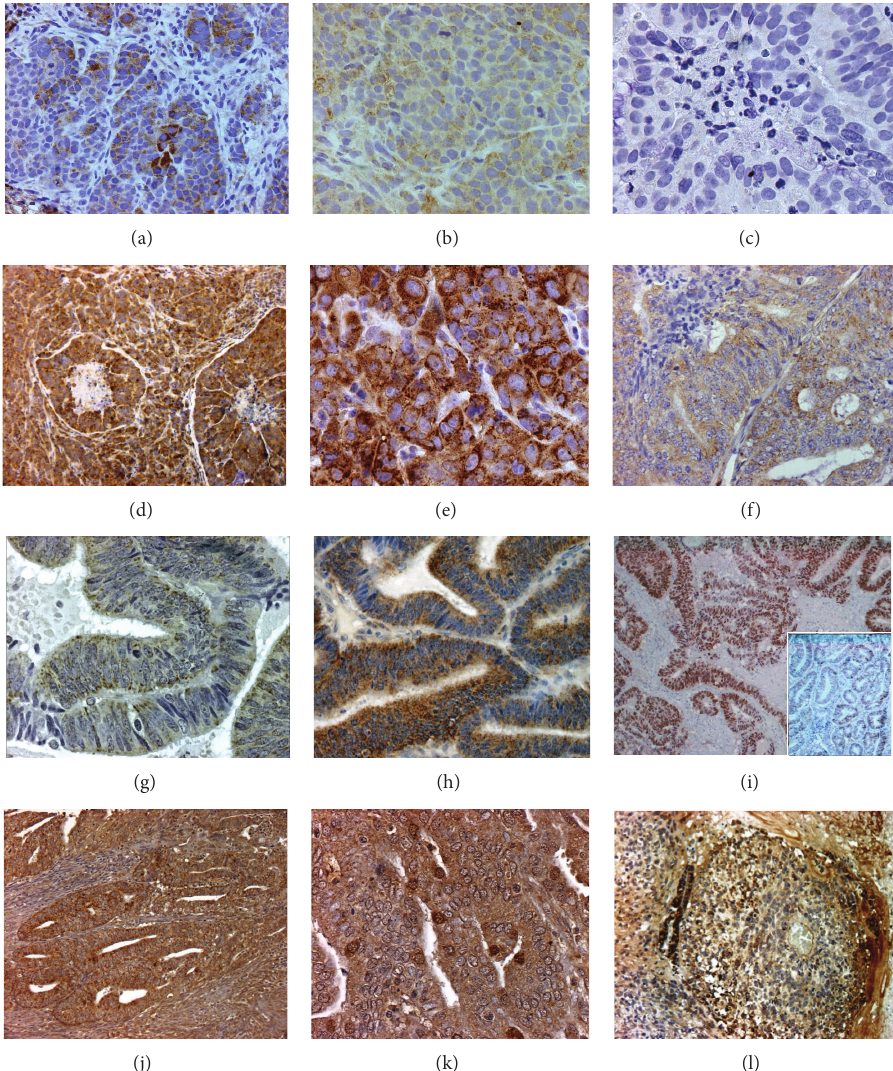
Figure 6: GPER expression in xenografts of Ishikawa H cells and Hec50 endometrial cancer cells as well as representative type I and type II human primary tumors. (a)–(e) Immunohistochemical staining of GPER in xenograft tumors of Ishikawa H cells ((a), 20x; (b), 40x) demonstrating the areas most strongly positive for GPER, and representative xenograft tumors of Hec50 cells ((d), 20x; (e), 40x; (c), negative control (irrelevant primary antibody), 40x). ((f)–(h)) GPER staining of a recurrent adenocarcinoma with endometrioid features ((f), mouse xenograftofpatienttumor,40x;(g),patienttumor,40x;(h),patienttumor,20x,demonstratingfocalpositivity;(i),ER 𝛼 andPR(inset)staining of the same patient tumor). ((j)–(l)) GPER staining from a patient with Stage IA carcinosarcoma ((j), mouse xenograft of patient tumor, 20x, illustrating diffuse positive staining in both epithelial and stromal fractions; (k), patient tumor, 40x; (l), patient tumor, 20x, demonstrating similarly strong GPER staining in both the epithelial and stromal